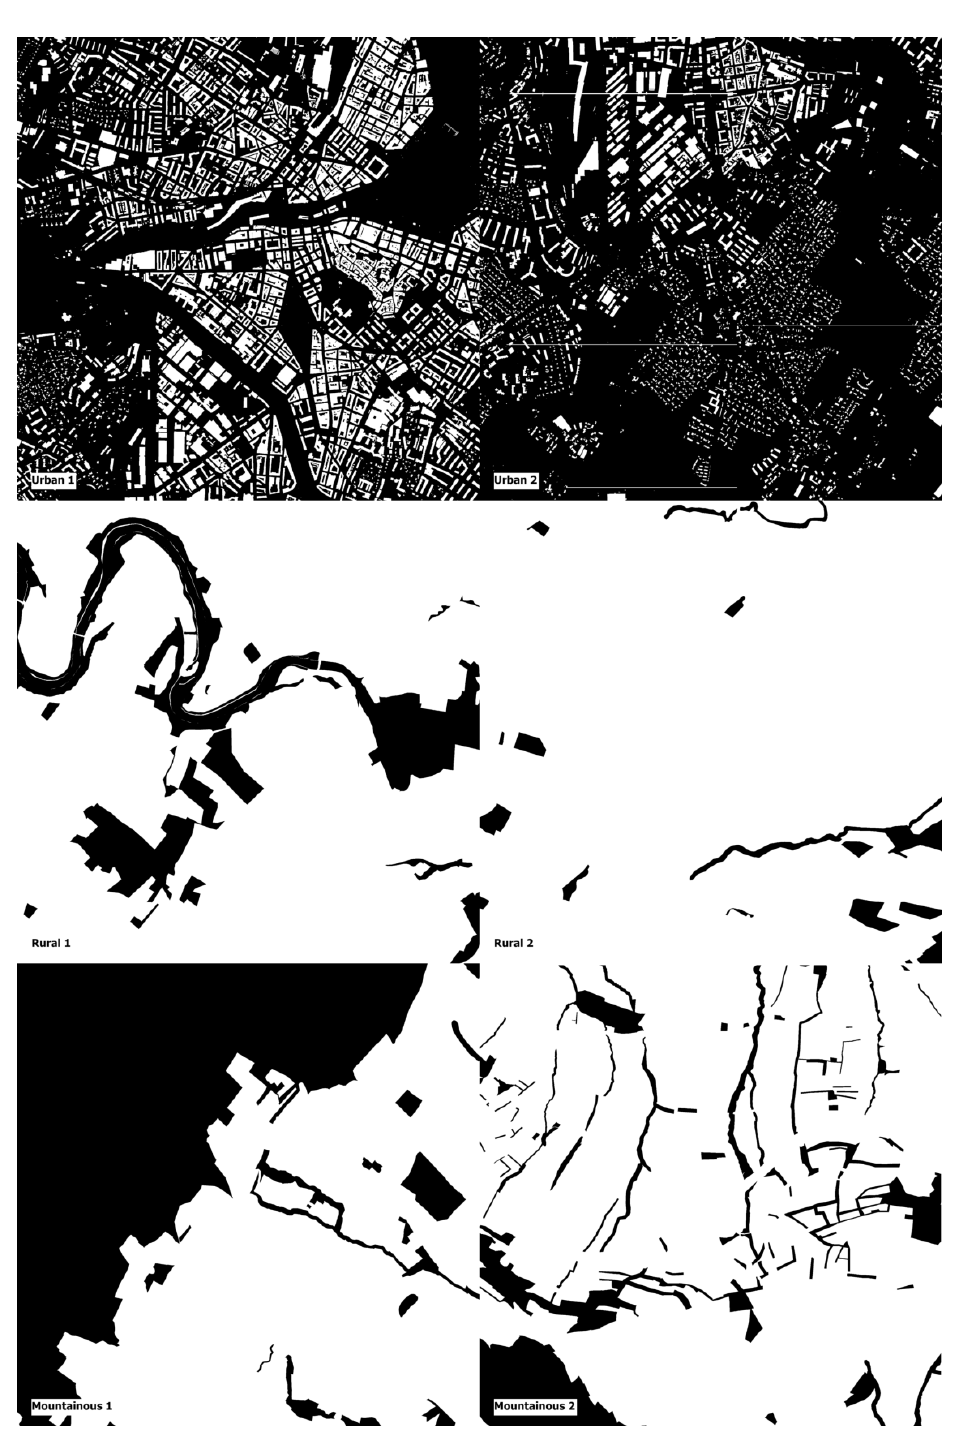
Figure 7. Illustration of the 6 tiles with different types of masks (0—black: excluded pixel, 1—white: included pixel).